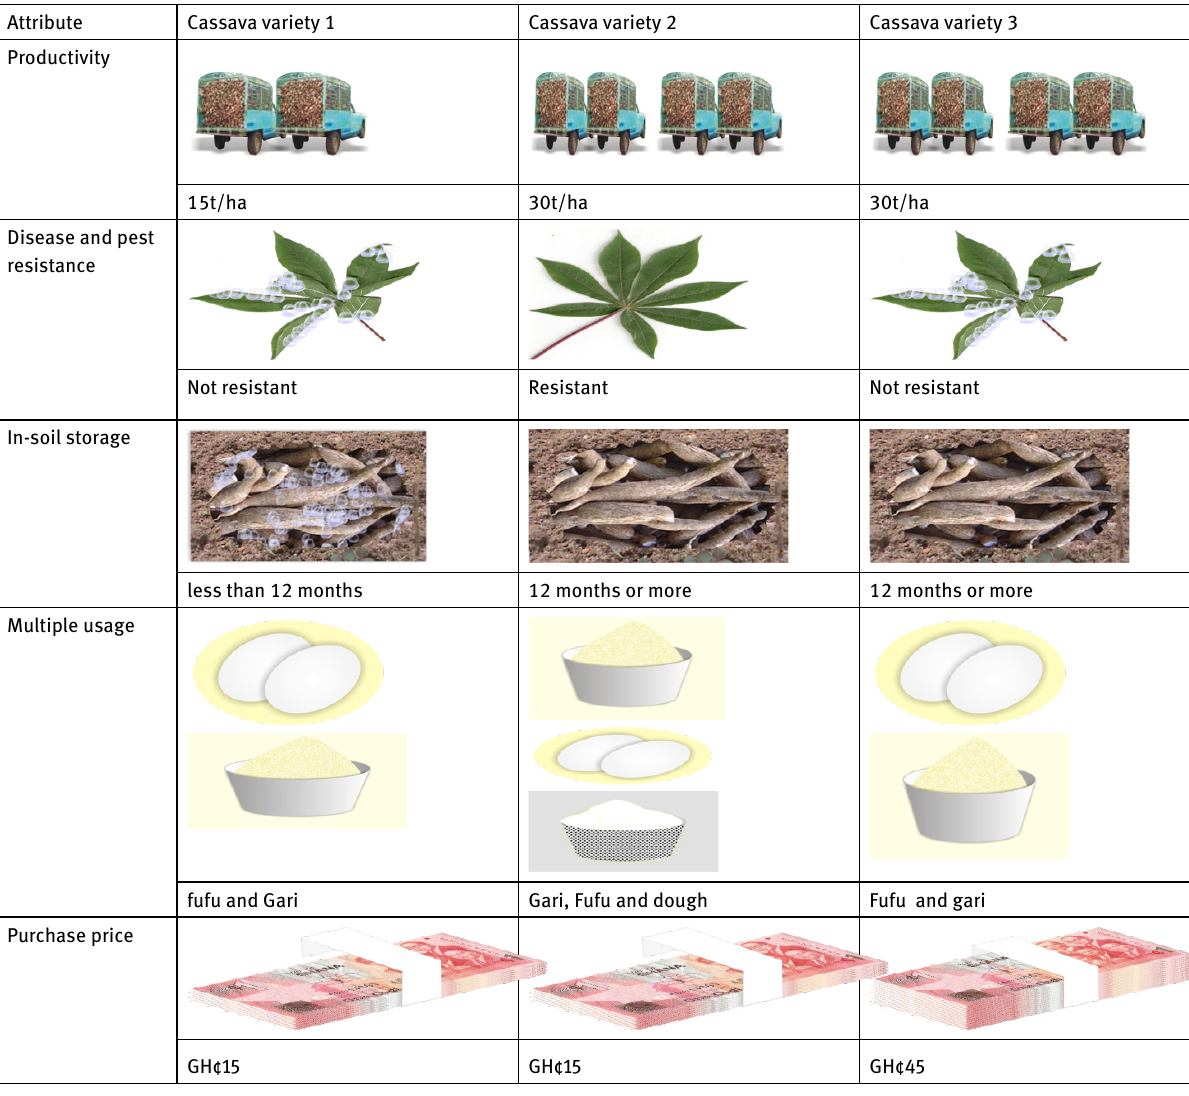
Figure 2: An example of a choice